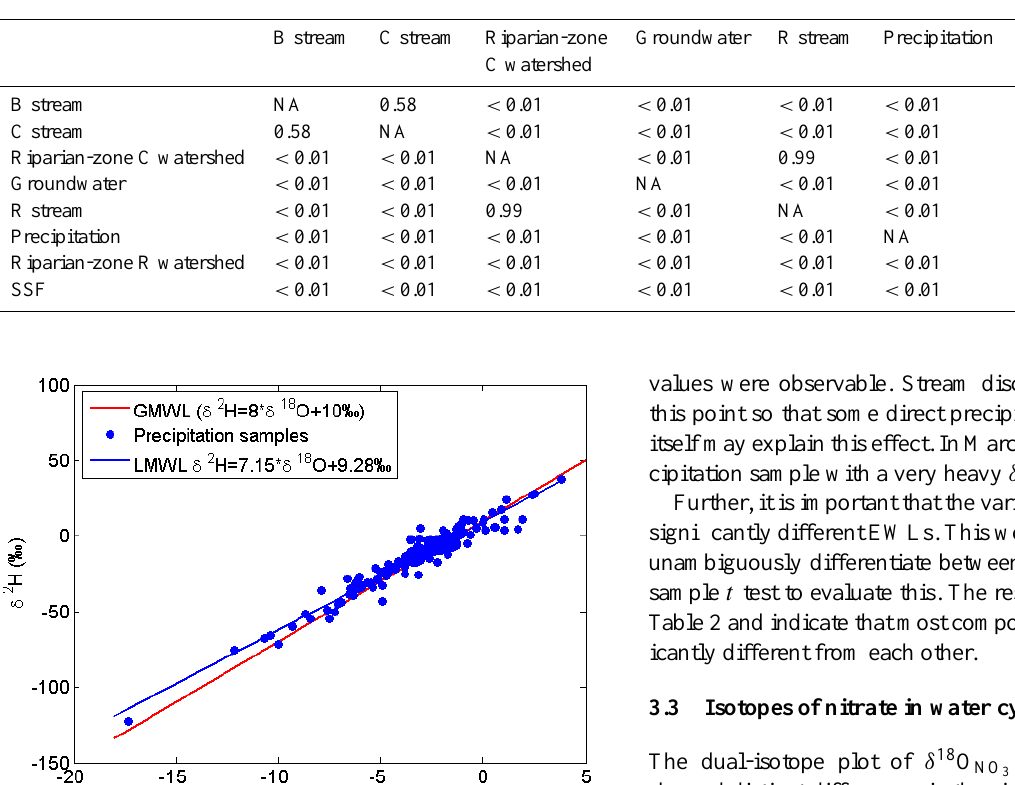
Table 2. Values of p to evaluate the differences between the LMWL/EWLs of the different water compartments used to constrain the conceptual model.